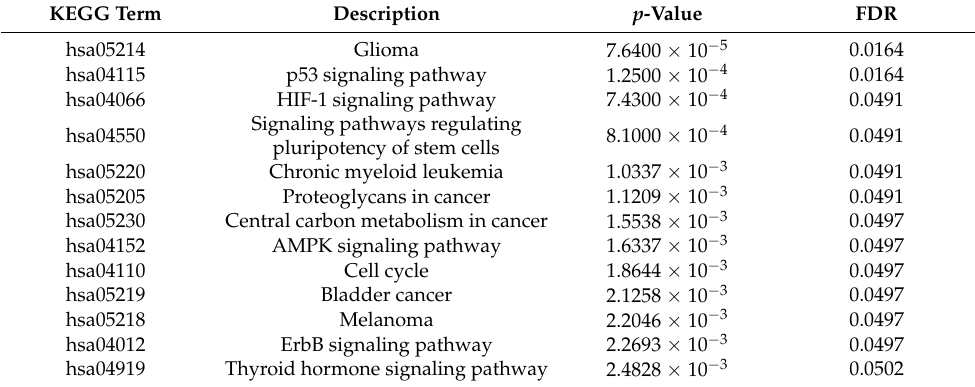
Table 2. Summary of Kyoto Encyclopedia of Genes and Genomes (KEGG) pathways for the 14 “high-confidence” miRNAs from miRBase with potential target sites on SARS-CoV-2. KEGG Term Description p -Value FDR hsa05214 Glioma 7.6400 × 10 − 5 0.0164 hsa04115 p53 signaling pathway 1.2500 × 10 − 4 0.0164 hsa04066 HIF-1 signaling pathway 7.4300 × 10 − 4 0.0491 Signaling pathways regulating hsa04550 8.1000 × 10 − 4 0.0491 pluripotency of stem cells hsa05220 Chronic myeloid leukemia 1.0337 × 10 − 3 0.0491 hsa05205 Proteoglycans in cancer Central carbon metabolism in cancer AMPK signaling pathway Bladder cancer Melanoma 2.2046 × 10 − 3 0.0497 hsa04012 ErbB signaling pathway 2.2693 × 10 − 3 0.0497 hsa04919 Thyroid hormone signaling pathway 2.4828 × 10 − 3 0.0502 FDR: false discovery